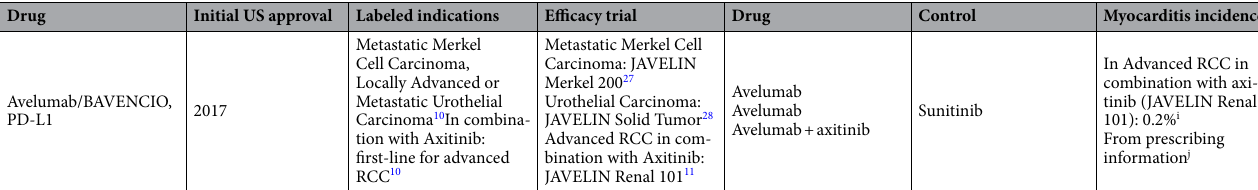
Table 1. Summary of Myocarditis occurrence in clinical trials for immune checkpoint inhibitors. RCC renal cell carcinoma, mRCC metastatic renal cell carcinoma, NSCLC non-small cell lung cancer, SCLC small cell lung cancer, CSCC cutaneous squamous cell carcinoma. a In CA184-029, the following clinically significant irAEs were seen in less than 1% of YERVOY-treated patients unless specified: cytopenias, eosinophilia (2.1%), pancreatitis (1.3%), meningitis, pneumonitis, sarcoidosis, pericarditis, uveitis, and fatal myocarditis [see Adverse Reactions (6.1)] 5 . b Fatal adverse reactions occurred in 1.7% of patients; these included events of pneumonitis (4 patients), myocarditis, acute kidney injury, shock, hyperglycemia, multi- system organ failure, and renal failure 5 . c Other clinically important adverse reactions that occurred in less than 10% of patients on KEYNOTE-087 included infusion reactions (9%), hyperthyroidism (3%), pneumonitis (3%), uveitis and myositis (1% each), and myelitis and myocarditis (0.5% each) 6 . d Of the 11 patients (2.6%) in the pembrolizumab–axitinib group who died from adverse events, 4 (0.9%) died from treatment-related adverse events (from myasthenia gravis, myocarditis, necrotizing fasciitis, and pneumonitis, in 1 patient each) 16 . e